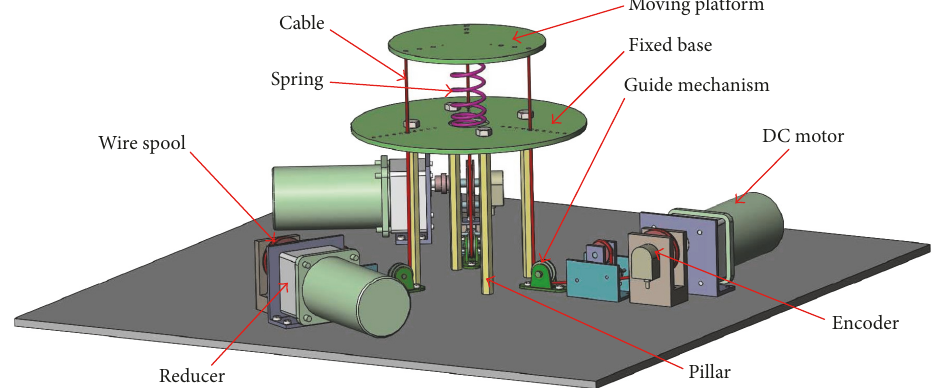
Figure 3: Solid model of the cable-driven parallel robot with a flexible spring.